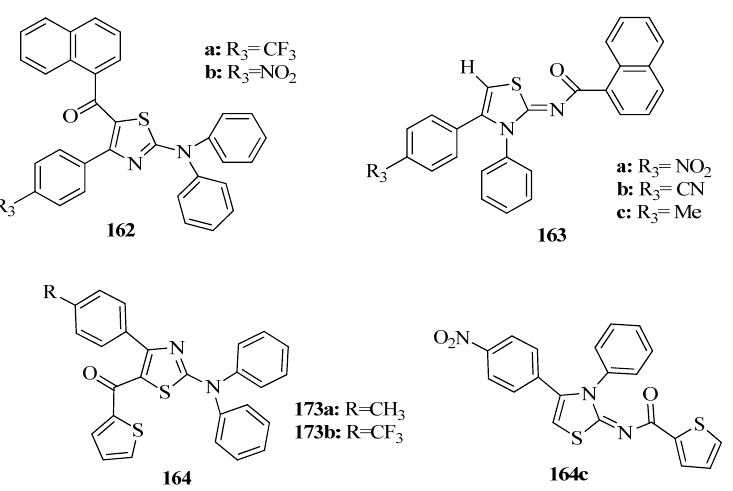
Figure 63. Structure of 2-amino-4-arylthiazol-5-ylnaphthalen-1-yl methanone derivatives, 2- (substituted)-4-(4-substituted phenyl)thiazol-5-yl)(thiophen-2-yl)methanone and N-(3-phenyl-4-(4- (substituted phenyl)thiazol- 2(3H)-ylidene)thiophene-2-carbox-amide.